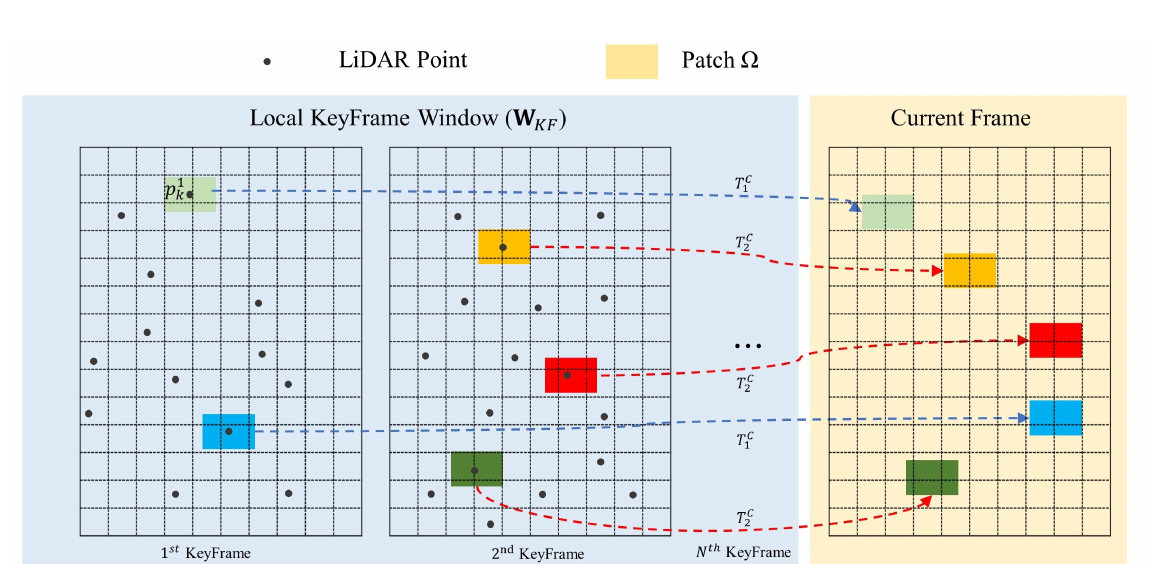
Figure 4. Illustration of sliding window-based optimization, the light blue area represents the local keyframes window ( W KF ) which consists of N keyframes, and each keyframe has its image data and LiDAR points. Black dots represent the salient LiDAR points and colored rectangles represent the patches lying in the image. A point p 1 in the first keyframe of k ( W KF ) is projected into current frame with the transform T c . A photometric residuals are then calculated between the 1 patch at the existing point and the other patch at a projected